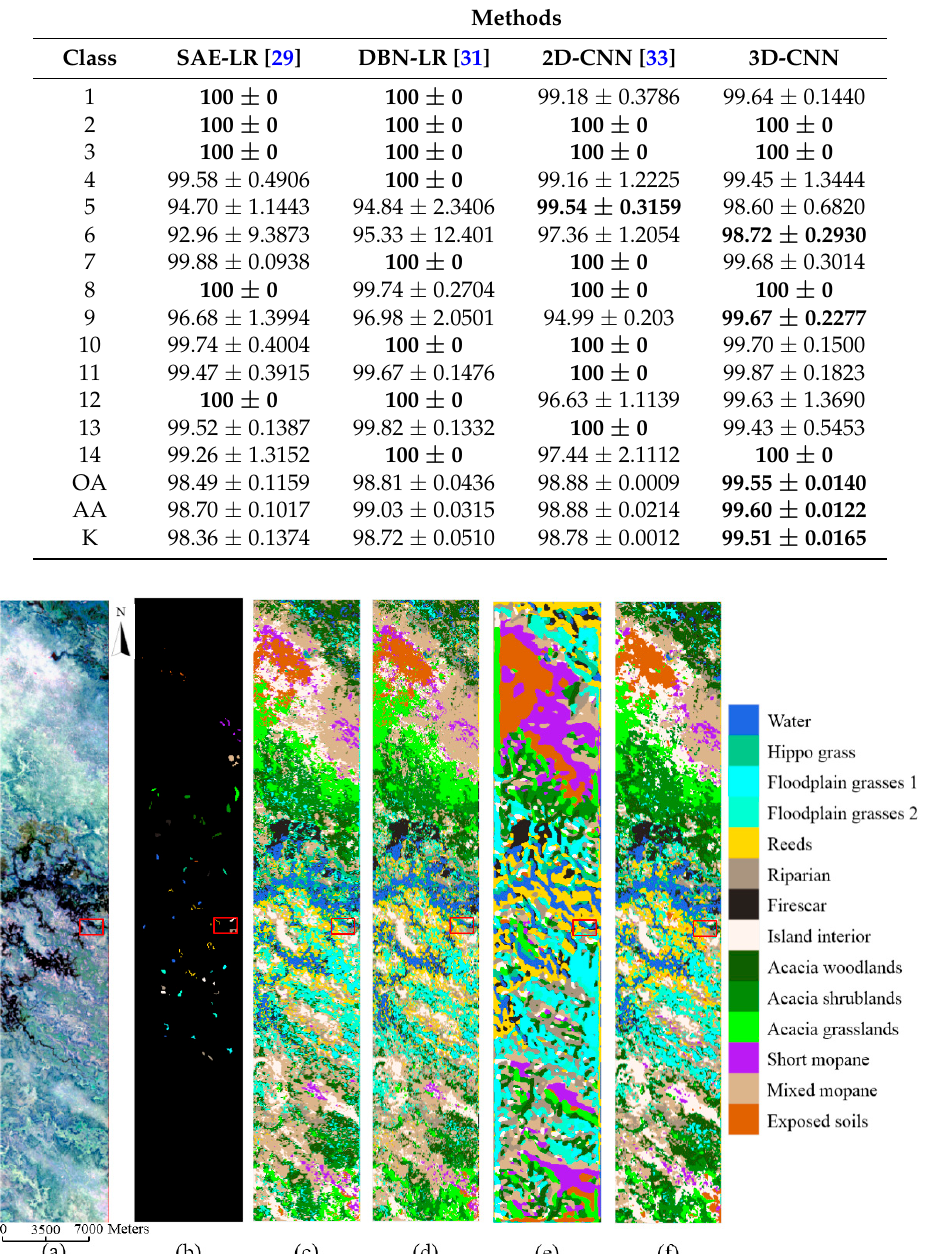
Table 7. Classification results (%) of Botswana scene.